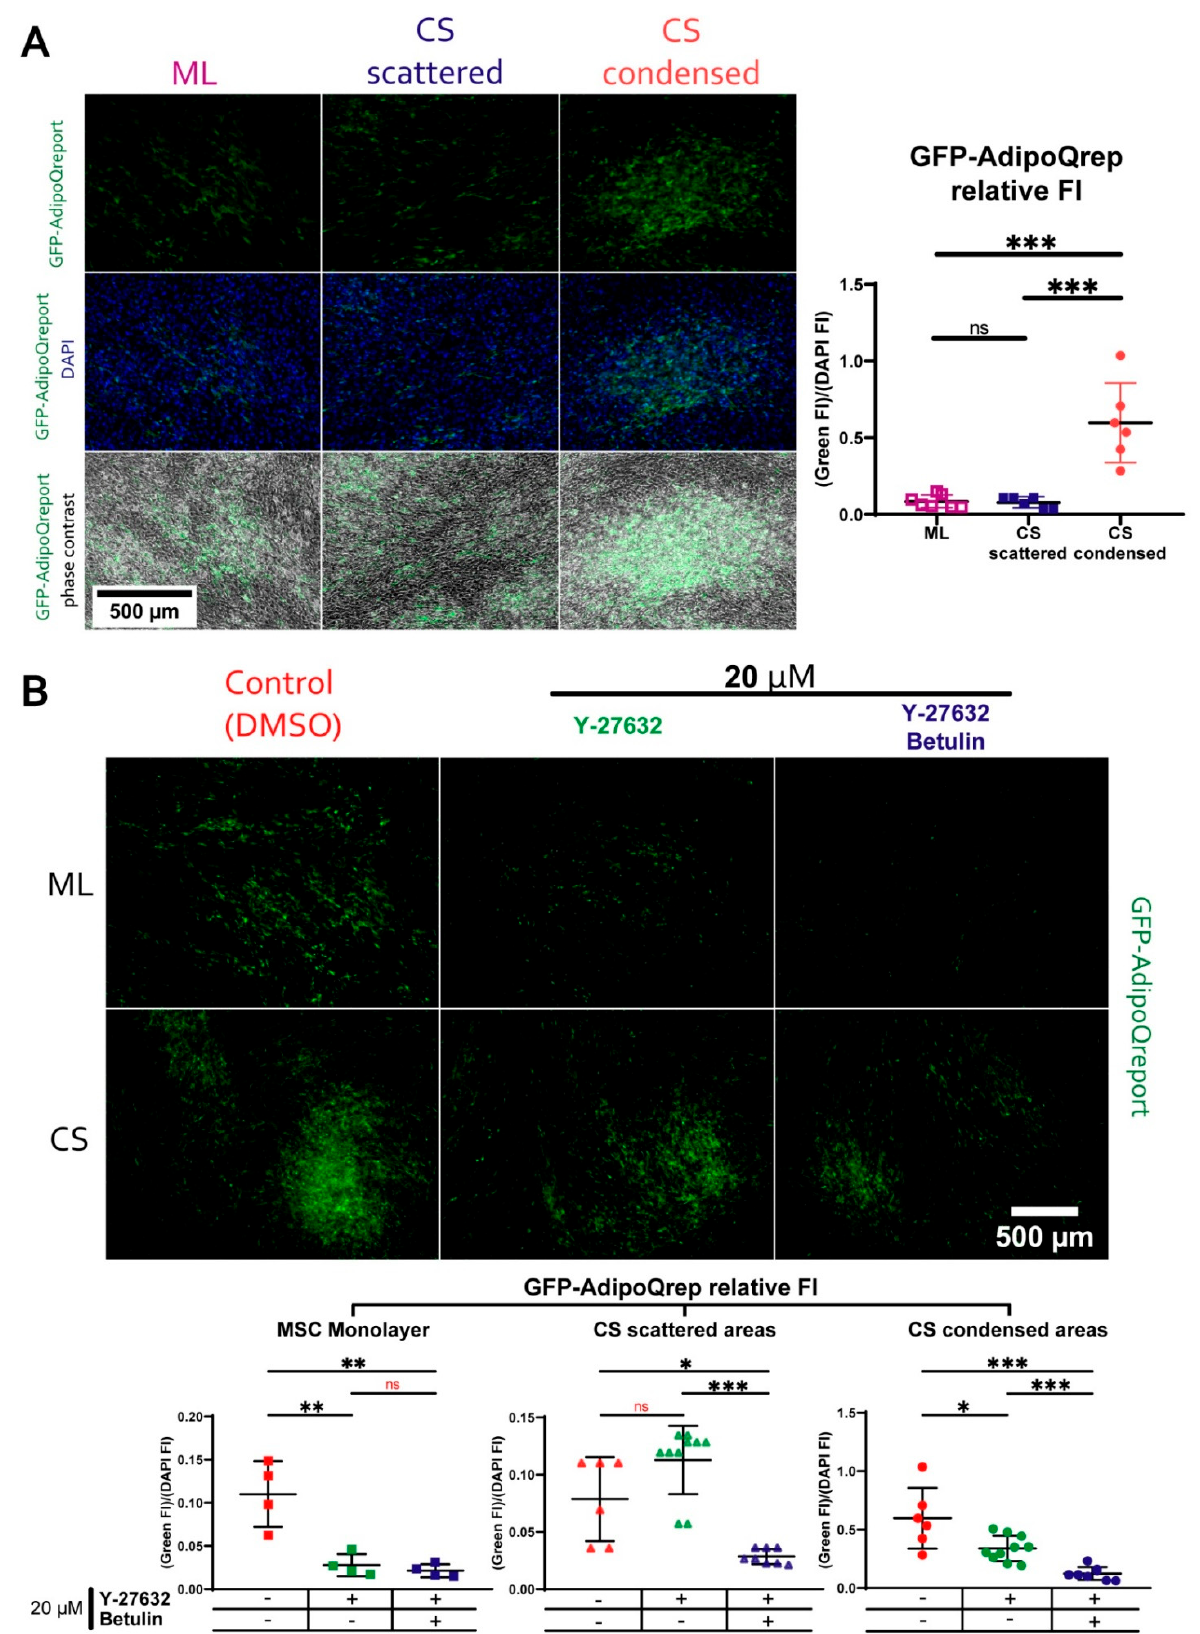
Figure 11. Adiponectin (AdipoQ) gene expression during adipogenic differentiation is differentially mediated by the Rho/ROCK-1/2 pathway in the monolayer culture and cell sheet (CS). Adiponectin promoter bearing genes expression in MSC in the monolayer and CS-condensed and scattered areas have different dependence on the ROCK pathways inhibi-